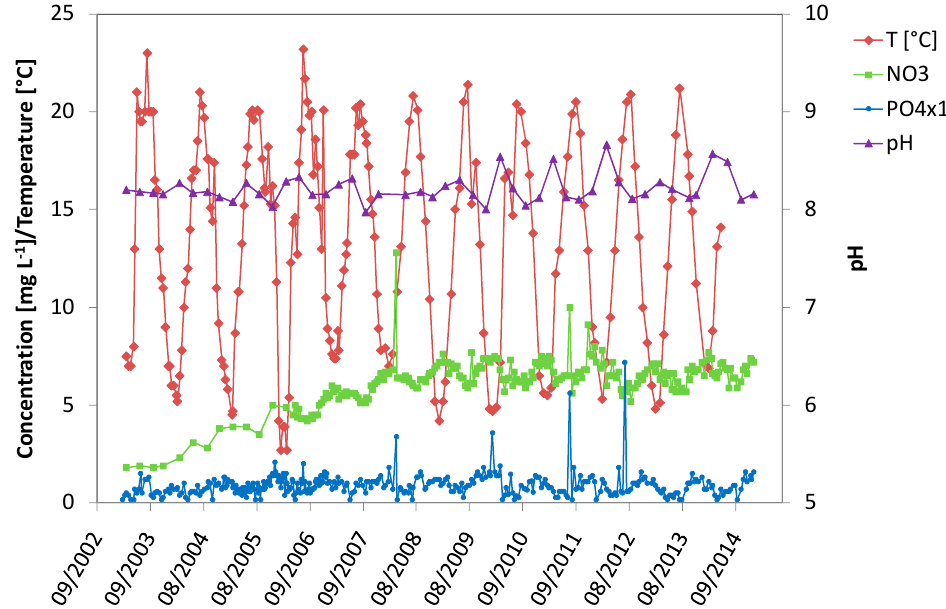
Figure 5. Temperature, pH, NO 3 and PO 4 data of DLV Lake from 2003 to 2014. Maximum values of temperature and pH typically occurred in summer whereas maximum NO 3 and PO 4 vales were observed in winter.